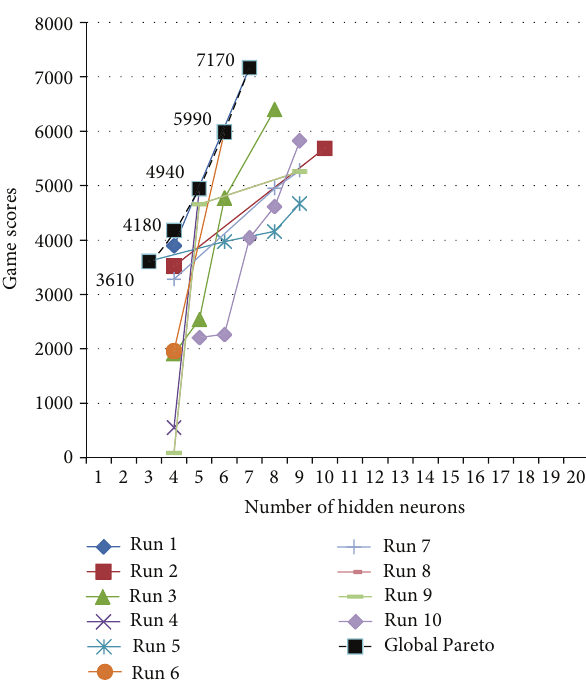
Figure 3: The global Pareto-frontier solutions obtained across all 10 runs using multiobjective